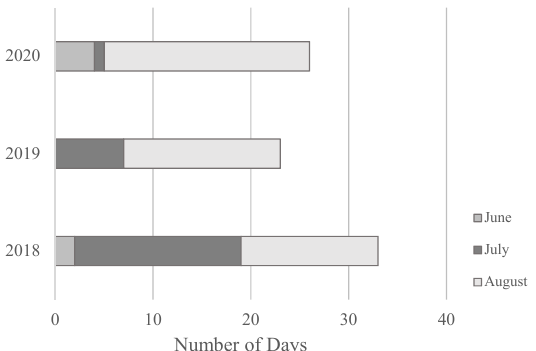
Figure 5. ( a ) Monthly average temperature from 2018 to 2020; ( b ) monthly maximum temperature